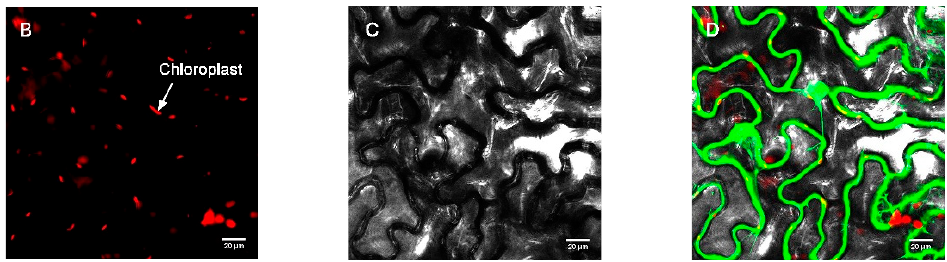
Figure 3. Empty vector control. ( A ) Fluorescence channel. ( B ) Chloroplast fluorescence channel. ( C ) Bright field. ( D ) Superimposed plot.